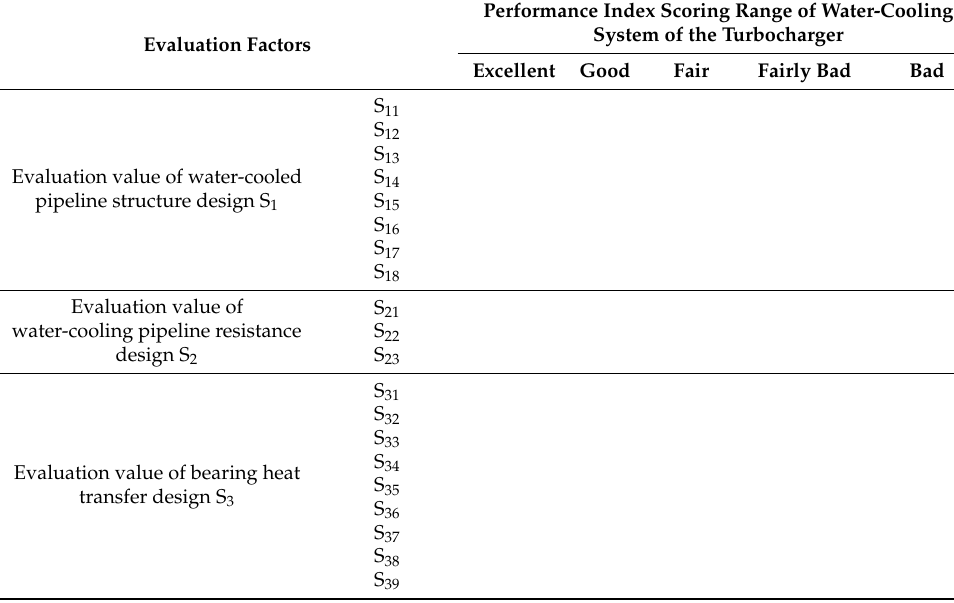
Table 2. Data collection table for performance